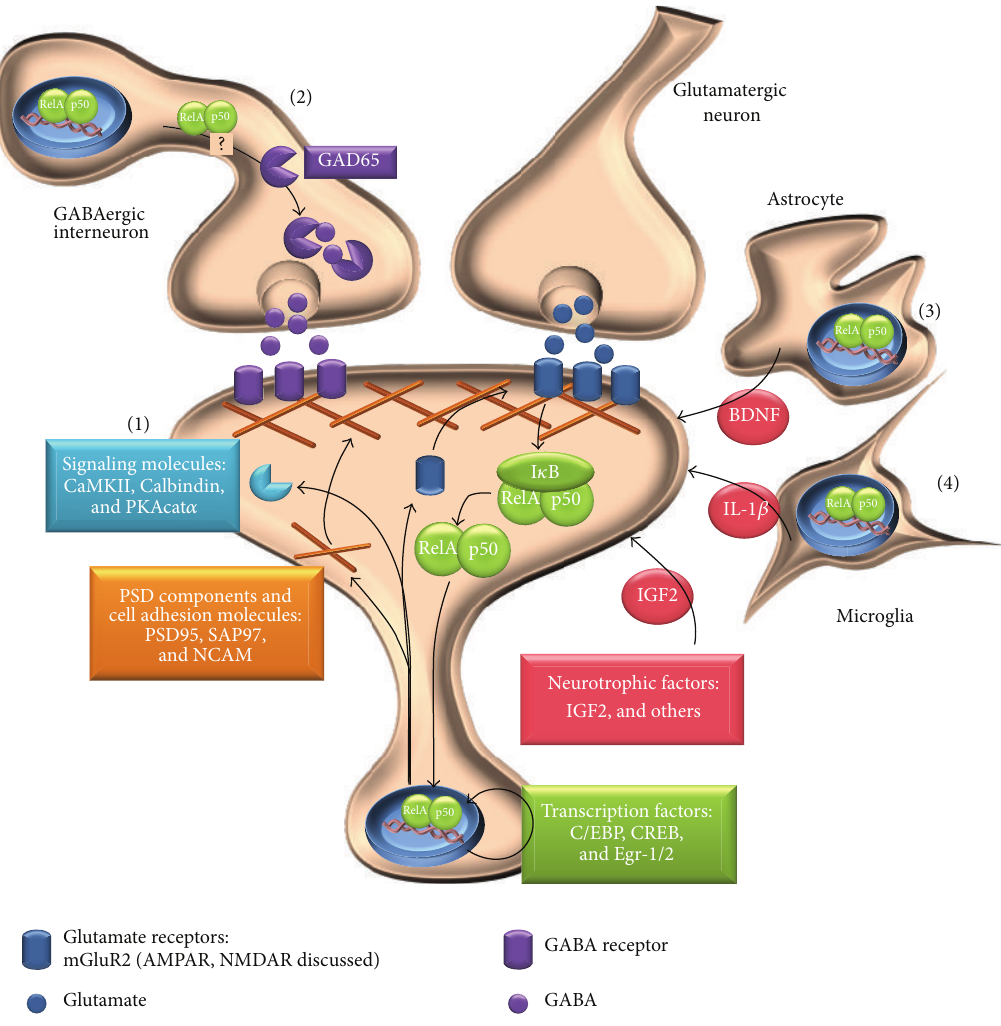
Figure 1: Overview of NF- 𝜅 B regulated components in synaptic plasticity. (1) At the postsynapse NF- 𝜅 B regulates the expression of various components of the postsynaptic density, ion channels/receptors, signaling molecules, and transcription factors that are involved in the modulationofsynaptictransmission.(2)Ininhibitoryneurons,NF- 𝜅